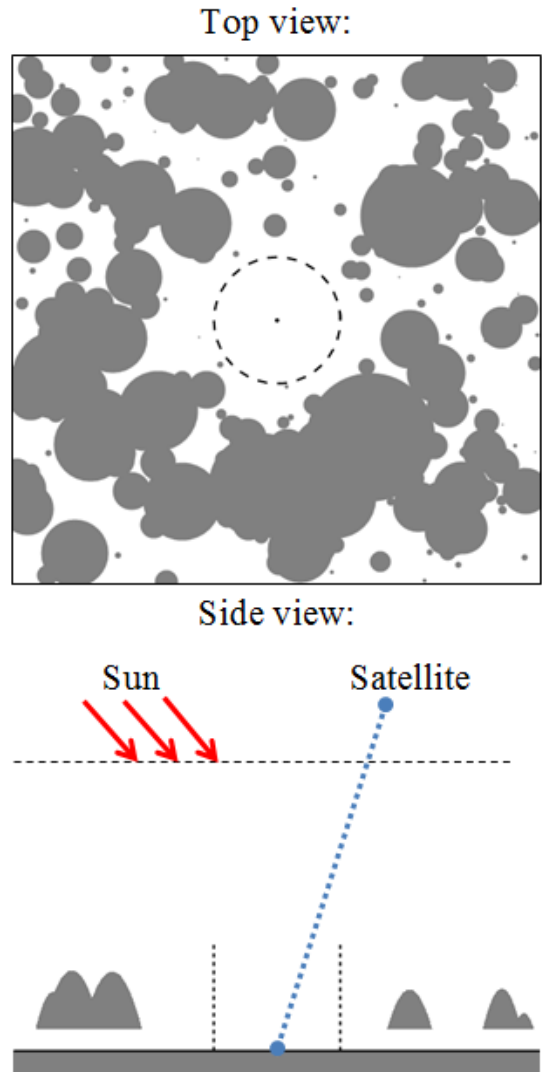
Figure 1. Geometric scheme of the problem